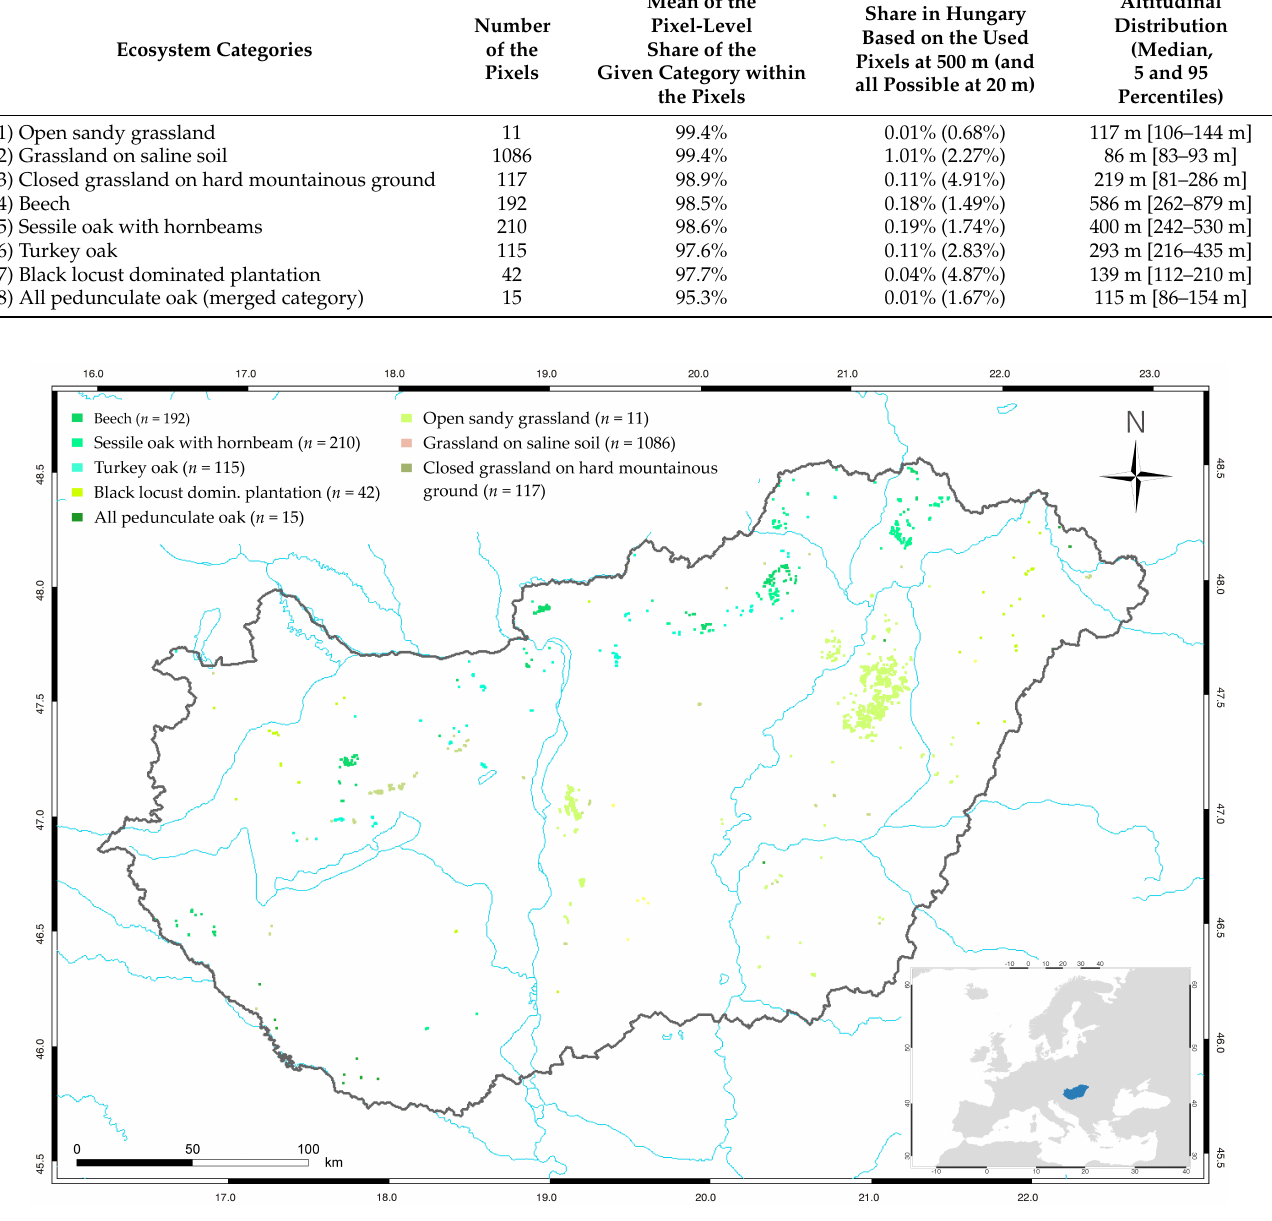
Figure 1. Map of the selected HKM MODIS pixels within Hungary with the dominant NÖSZT É P ecosystem categories. The map of the used ecosystem categories with all pixels and with the native 20 m × 20 m resolution is presented in Figure